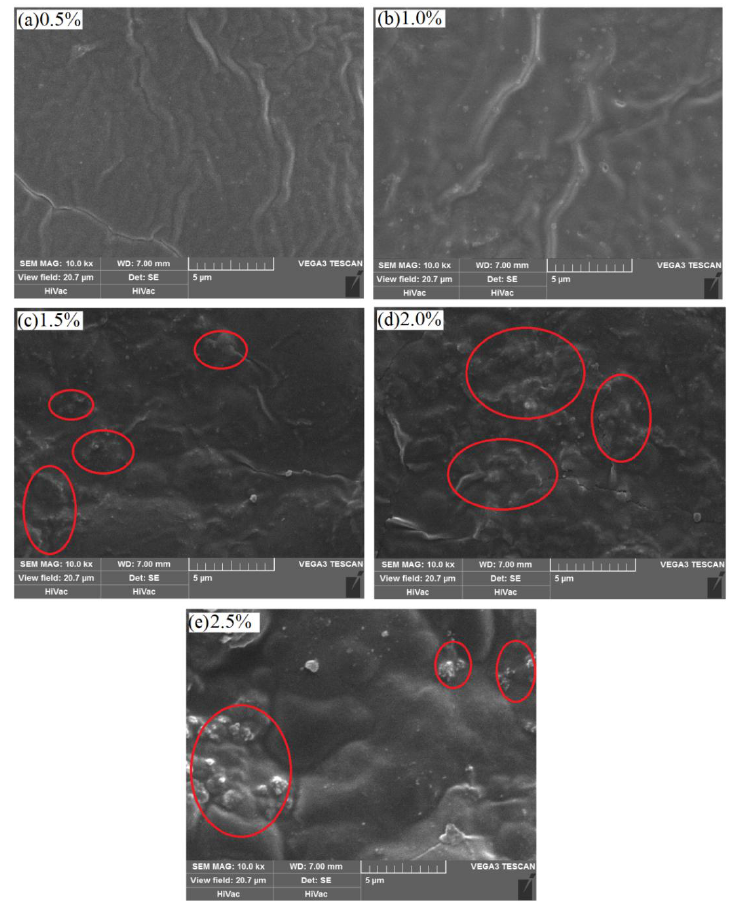
Figure 8. SEM (scanning electron microscopy) images of surface morphologies of 10% PVA/10% PAM blended hydrogels with different nano-silica contents, 10,000 × magnification: ( a ) 0.5% nano-silica content; ( b ) 1.0% nano-silica content; ( c ) 1.5% nano-silica content; ( d ) 2.0% nano-silica content; and ( e ) 2.5% nano-silica